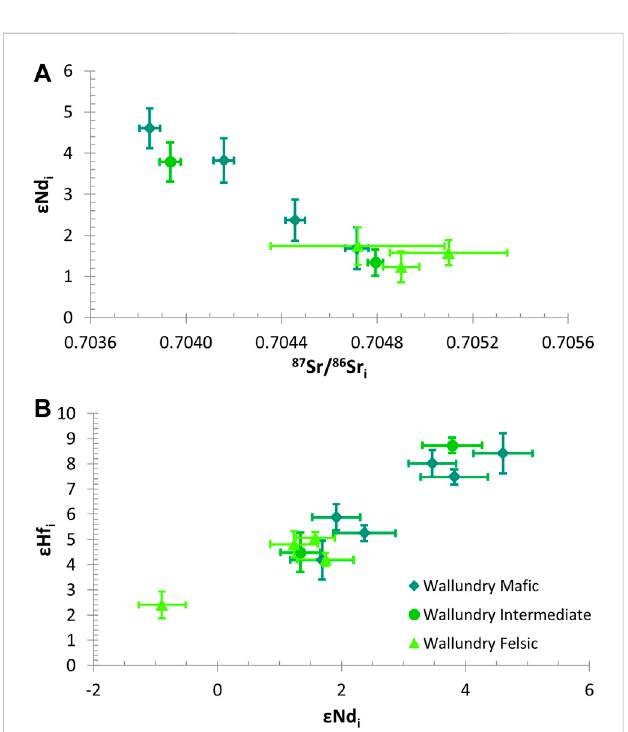
FIGURE 7 Wallundry Suite Sr-Nd-Hf isotope data acquired in this study (Tables 1 and Tables 2). (A) ε Nd i plotted against 87 Sr/ 86 Sr i for the Wallundry Suite. (B) ε Hf i plotted against ε Nd i for the Wallundry Suite (including the Mayfair Granite, for which Sr isotope data is lacking). Note the weak coupling between the evolution of the isotope compositions and the evolution from ma fi c to felsic samples.